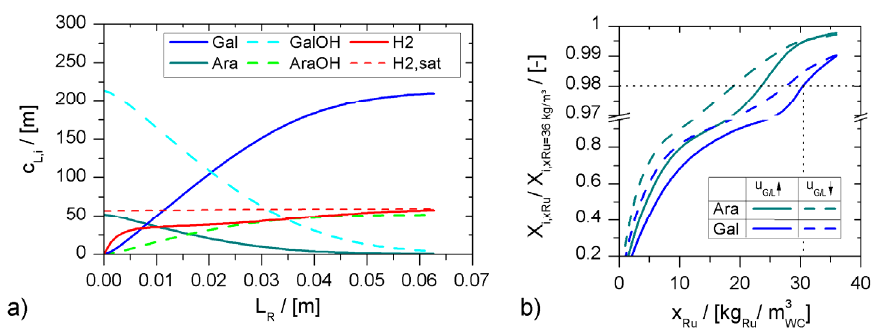
Figure 13. ( a ) Axial concentration profiles of all components in the liquid phase within the foam- packed minichannel reactor at 𝑢 (cid:3013),(cid:3046) = 0.017 m/s , 𝑢 (cid:3008),(cid:3046) = 0.17 m/s , 𝑥 (cid:3019)(cid:3048) = 30.5 kg (cid:2902)(cid:2931) /m (cid:2907)(cid:2887)(cid:2871) and ( b ) effect of reduced ruthenium content on the conversion of both reactants for high throughput (𝑢 (cid:3008)/(cid:3013) ↑ : 𝑢 (cid:3013),(cid:3046) = 0.017 m/s , 𝑢 (cid:3008),(cid:3046) = 0.17 m/s , 𝐿 (cid:3019) = 0.063 m ) and low throughput (𝑢 (cid:3008)/(cid:3013) ↓ : 𝑢 (cid:3013),(cid:3046) = 0.001 m/s , 𝑢 (cid:3008),(cid:3046) = 0.008 m/s , 𝐿 (cid:3019) = 0.008 m ).